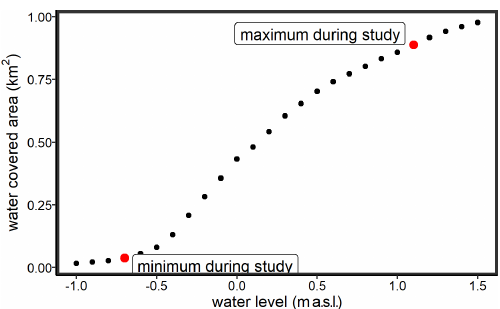
Figure A3. Hypsographic curve of the study area in increments of 0.1m. The red dots represent the observed range of the water level during the study. For a water level time series during the sampling period, see Fig.